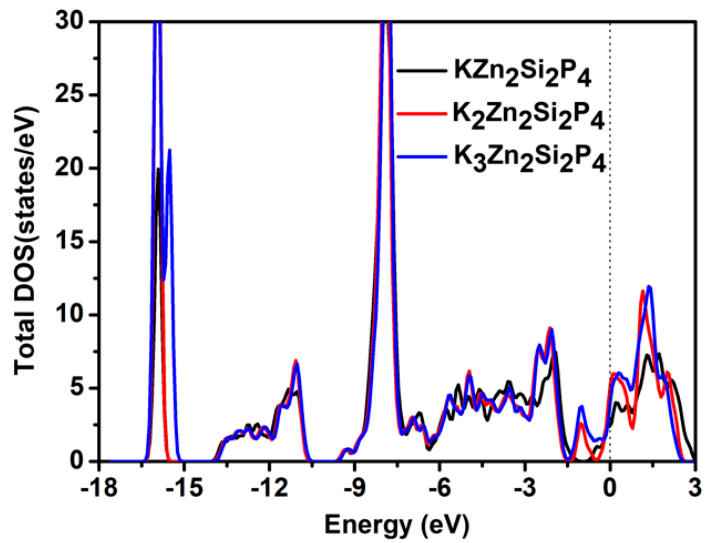
Figure 8. The total densities of states of KZn 2 Si 2 P 4 , K 2 Zn 2 Si 2 P 4 , and K 3 Zn 2 Si 2 P 4 .